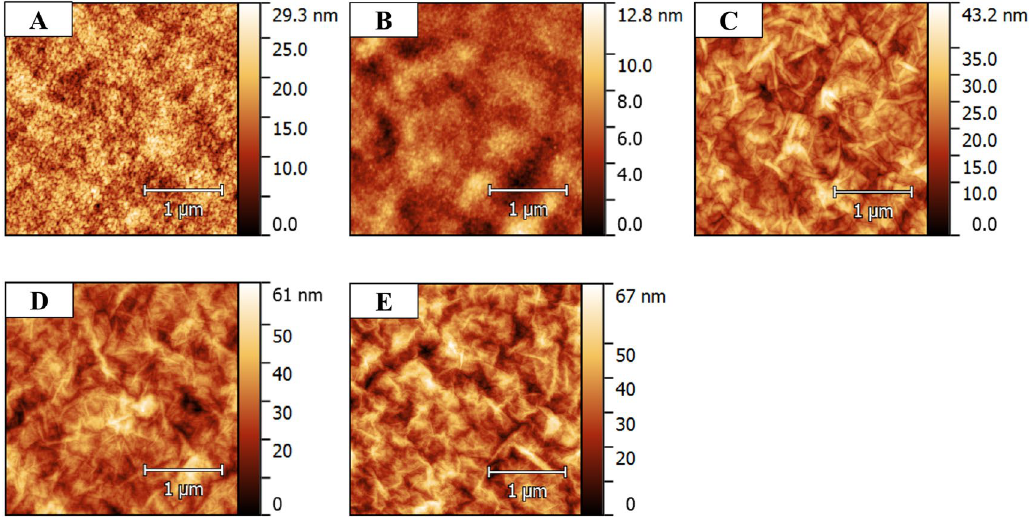
Figure 4. Tilted cross-sectional SEM image. Tilted cross-sectional SEM image of a (PDAC/PSS) 25 (GO/GO) 20.5 membrane.